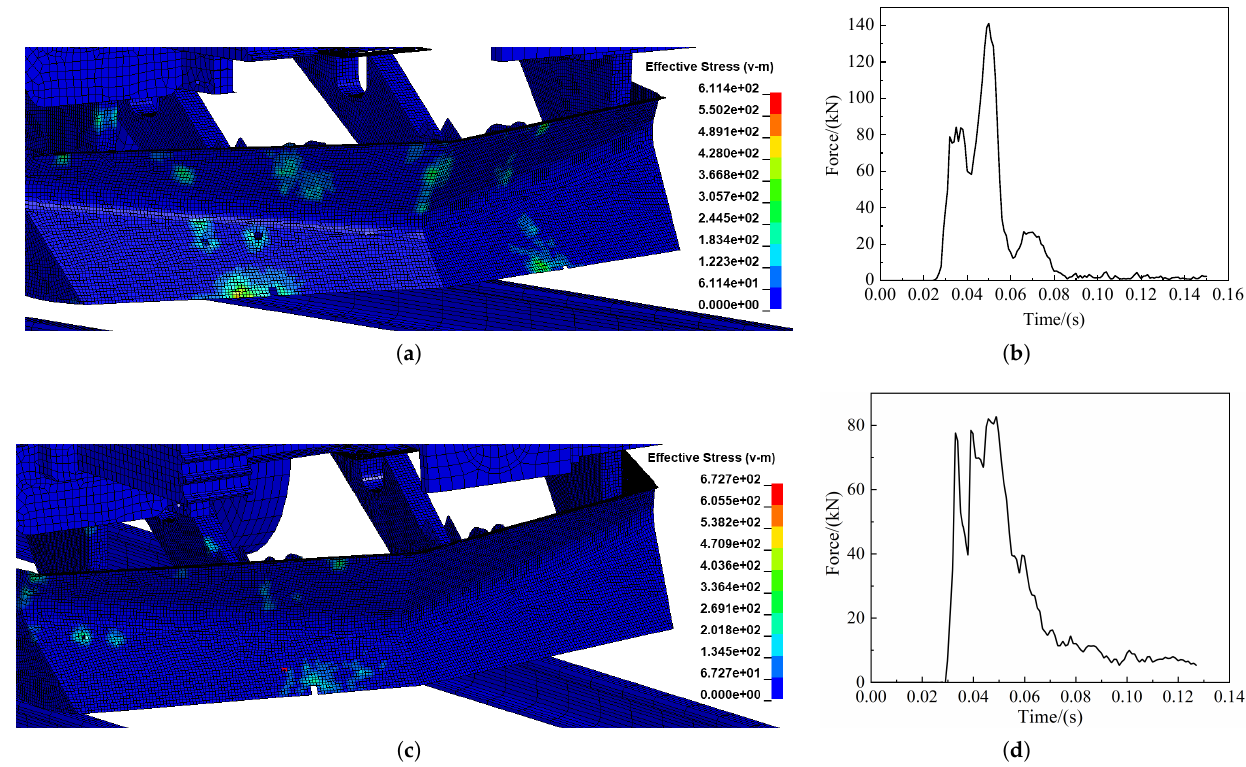
Figure 26. Changes in force on the cowcatcher: ( a ) Effective tress cloud diagram of the cowcatcher at 55 ms of collision; ( b ) Force curve of pig frontal collision cowcatcher; ( c ) Effective tress cloud diagram of the cowcatcher at 88 ms of collision; ( d ) Force curve of pig offset collision